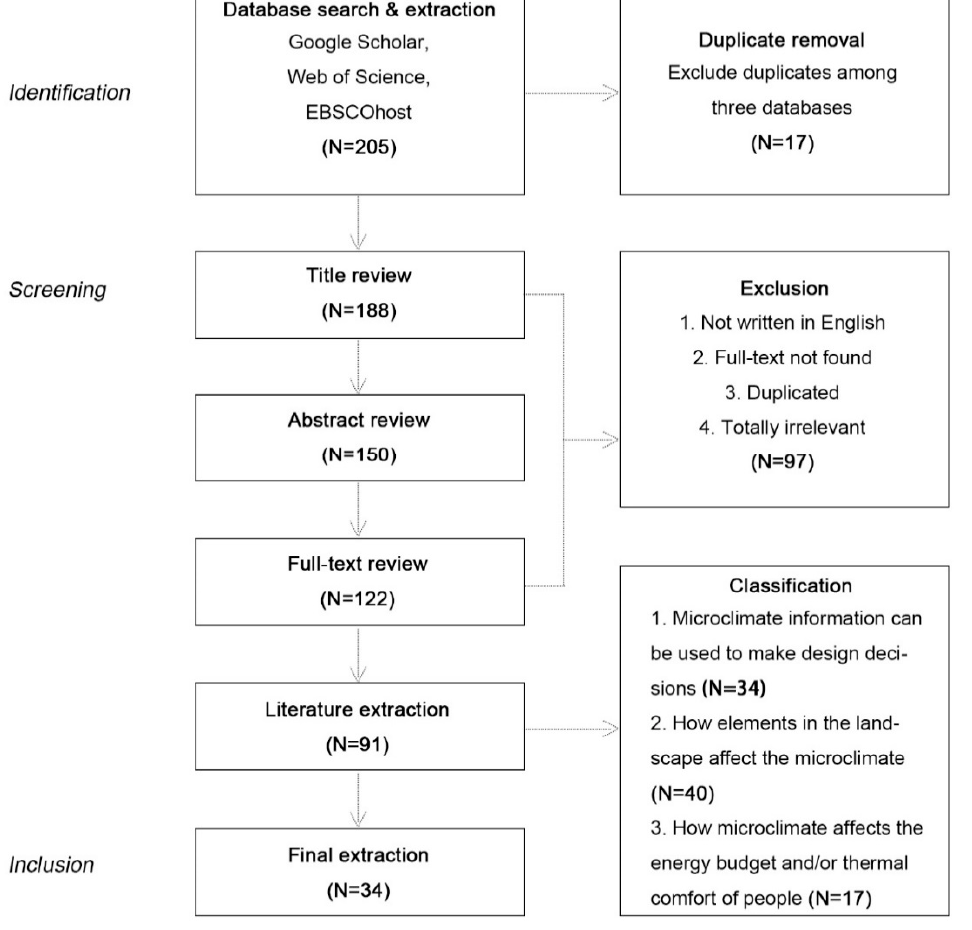
Figure 1. Review structure of literature search and selection.